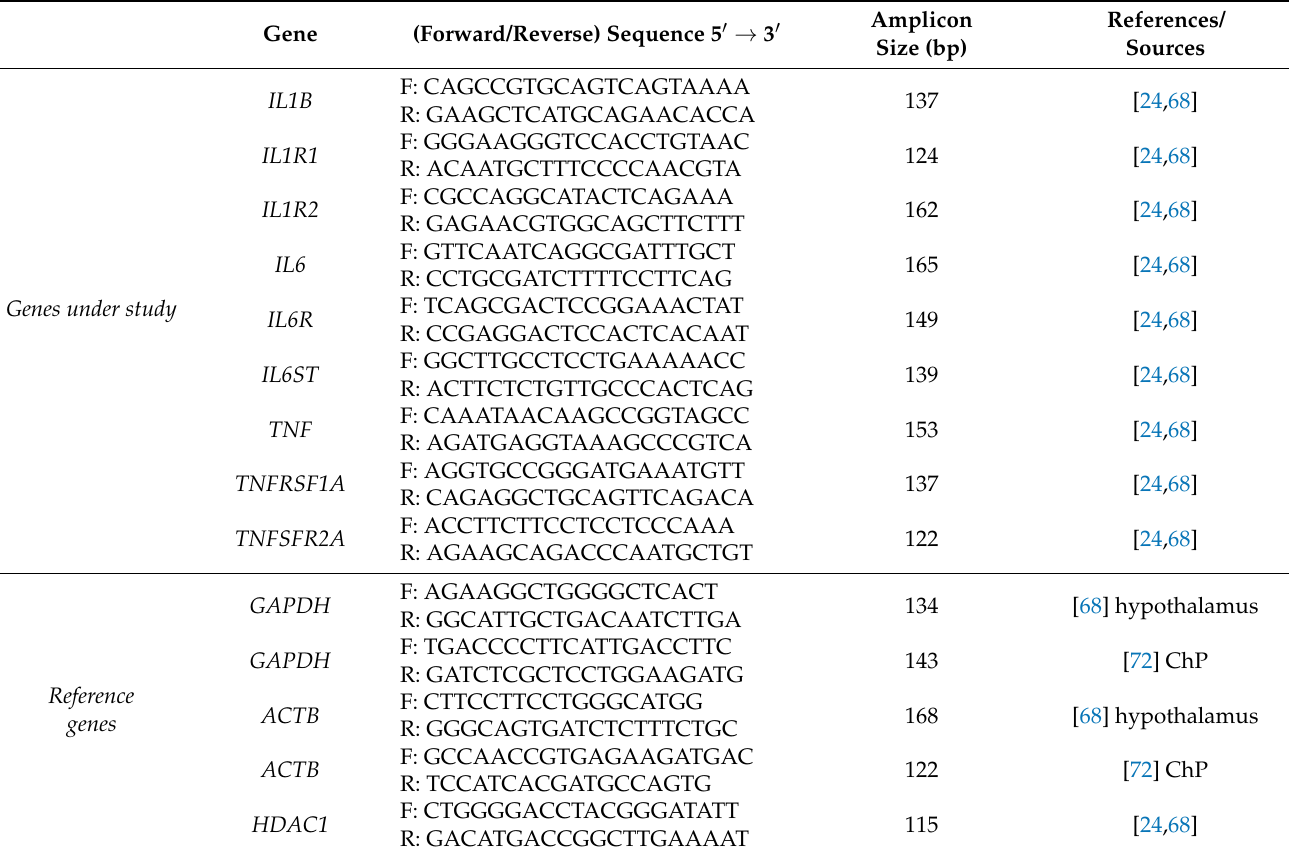
Table 4. Sequences of oligonucleotide primers used for real-time PCR in the hypothalamus and choroid plexus.